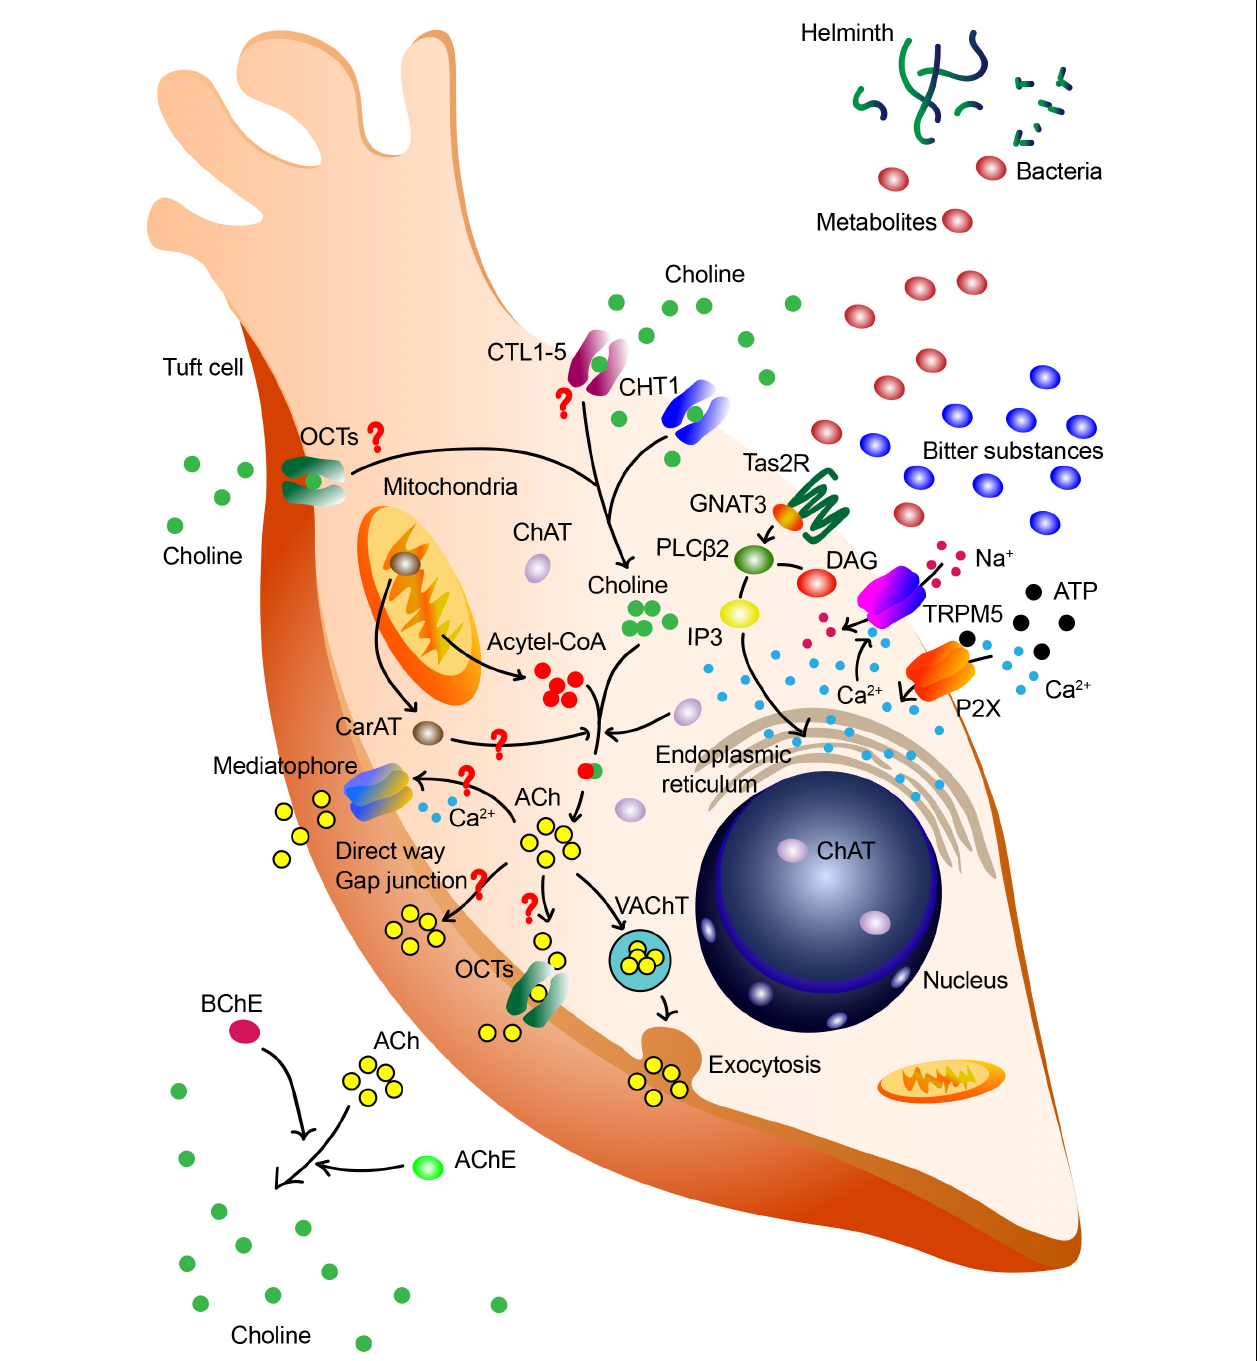
FIGURE 1 | Synthesis and release of ACh by tuft cells. Tuft cells may synthesize and release ACh through canonical biosynthesis pathway and other different pathways. Various signals, including bitter substances, ATP and bacterial metabolites, are capable of triggering this process. ATP increases intracellular Ca 2 + level via purinergic receptor P2X and the acceleration of Ca 2 + promotes the lease of ACh. Bitter substances and bacterial metabolites are sensed by taste receptor type 2 (Tas2R), influence downstream G-protein α -gustducin (GNAT3) and phospholipase C β 2 (PLC β 2), induce perturbation of intracellular Ca 2 + , activate TRPM5 and subsequently result in the release of ACh. In the canonical ACh biosynthesis pathway, extracellular choline is imported via CHT1, catalyzed into ACh with mitochondria-derived acetyl-CoA by ChAT in the cytoplasm. The ACh is then packaged into vesicles and released via VAChT in the exocytosis manner. Redundant ACh will be degraded into choline via acetylcholinesterase (AChE) and butyrylcholinesterase (BChE), and this extracellular choline may be re-uptake for the next cycle. However, there are still questions in the ACh biosynthesis in tuft cells. It is deduced that the synthesis of ACh may also be catalyzed by mitochondrial enzyme CarAT. In gastrointestinal and biliary tract, tuft cells lack the expression of VAChT and CHT1. These cells are speculated to re-uptake choline via CTL1-5 and OCTs, release ACh via direct way, OCT1/2-mediated way, and proteolipid mediatophore or even gap junction.